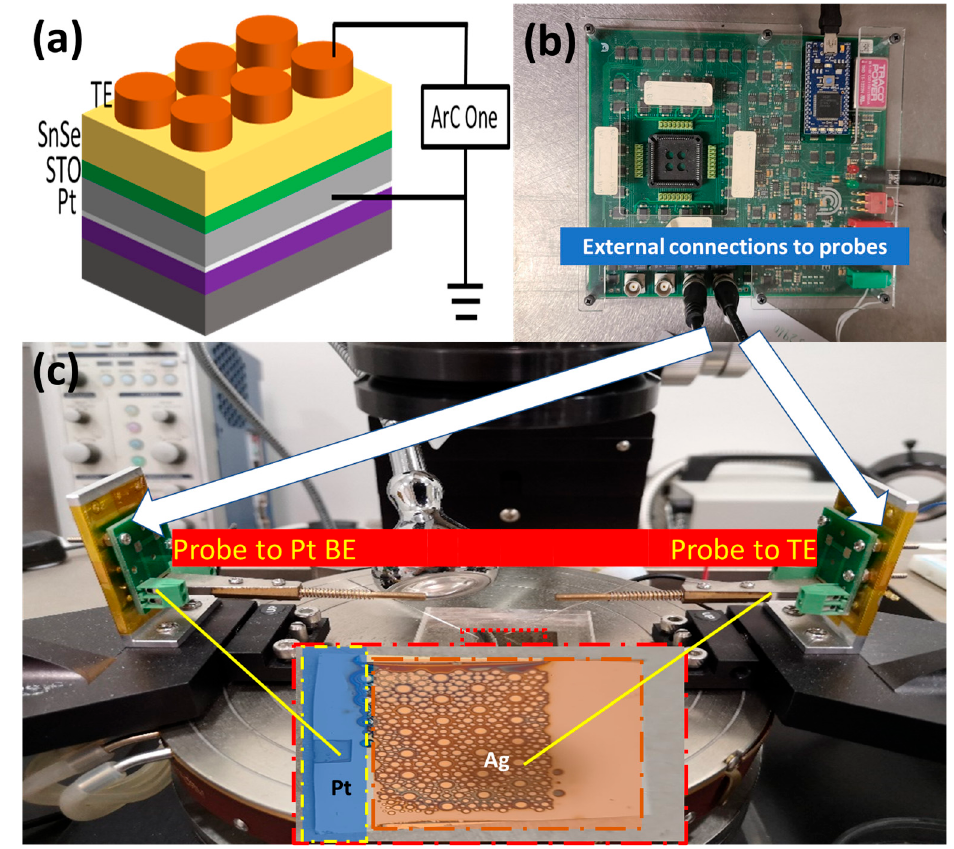
Figure 1. ( a ) Schematic of the TE/SnSe/STO/Pt memristor device with Cu or Ag top electrode (TE) connected to an ArC-One measurement instrument, ( b ) appearance of the ArC-One measurement instrument, and ( c ) the probe station and the measured devices.